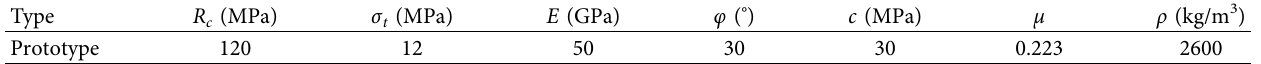
Table 1: Physicomechanical parameters of prototype used in the model test.